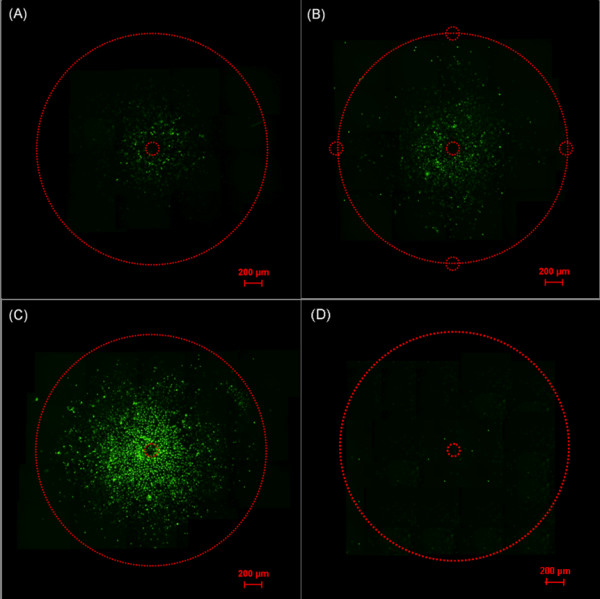
Fluorescence images of the PC3 cell monolayer exposed to nanoelectropulses with three different electrode configurations, (A) single-needle, (B) five-needle array, and (C) flat-cut cable, based on YO-PRO-1 permeabilization. 1000, 15 ns, 10 kV pulses at 50 Hz were delivered to cell monolayer. (D) Fluorescence image of un-pulsed PC3 cell monolayer with flat-cut cable as CTRL sample. To generate the fluorescence images of the area between the ground and high voltage electrodes, a series of 640 μm × 710 μm images are combined. The needles and the inner boundary of the ground electrodes are indicated with a small red dashed circle and outer red dashed circles, respectively.